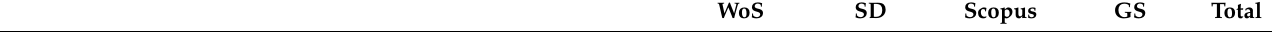
WoS SD Scopus GS